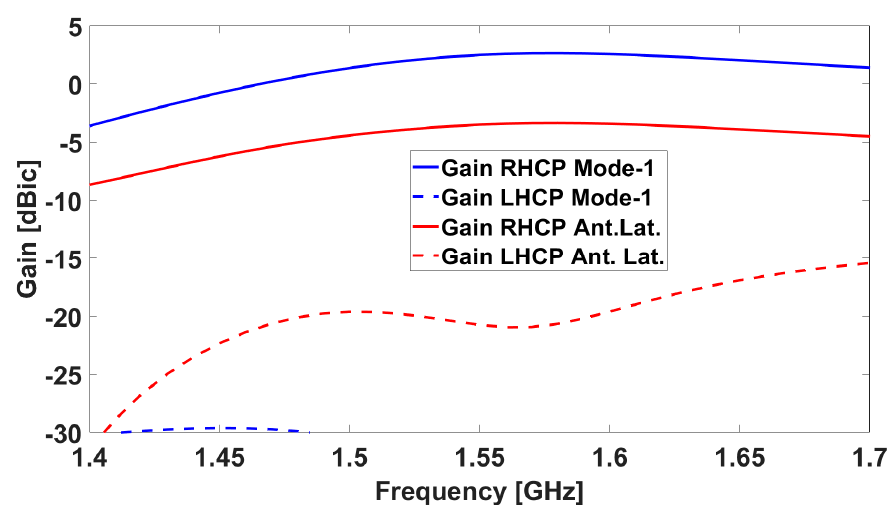
Figure 3. Simulated realized gain for one of the lateral antenna elements ( red ) and Mode 1 ( blue ): the solid line is the RHCP, while the dotted line is the LHCP.